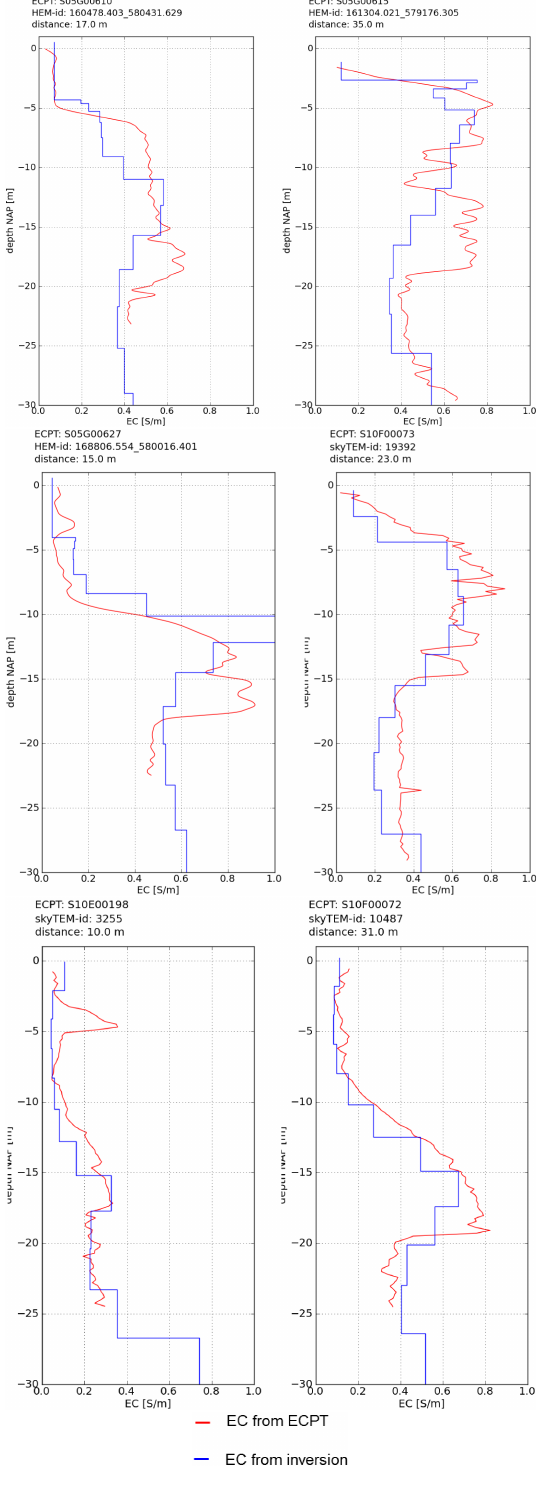
Fig. 7. Some selected examples of comparison between EC from ECPT and EC from airborne HEM and SkyTEM models (within 50 m), without a-priori